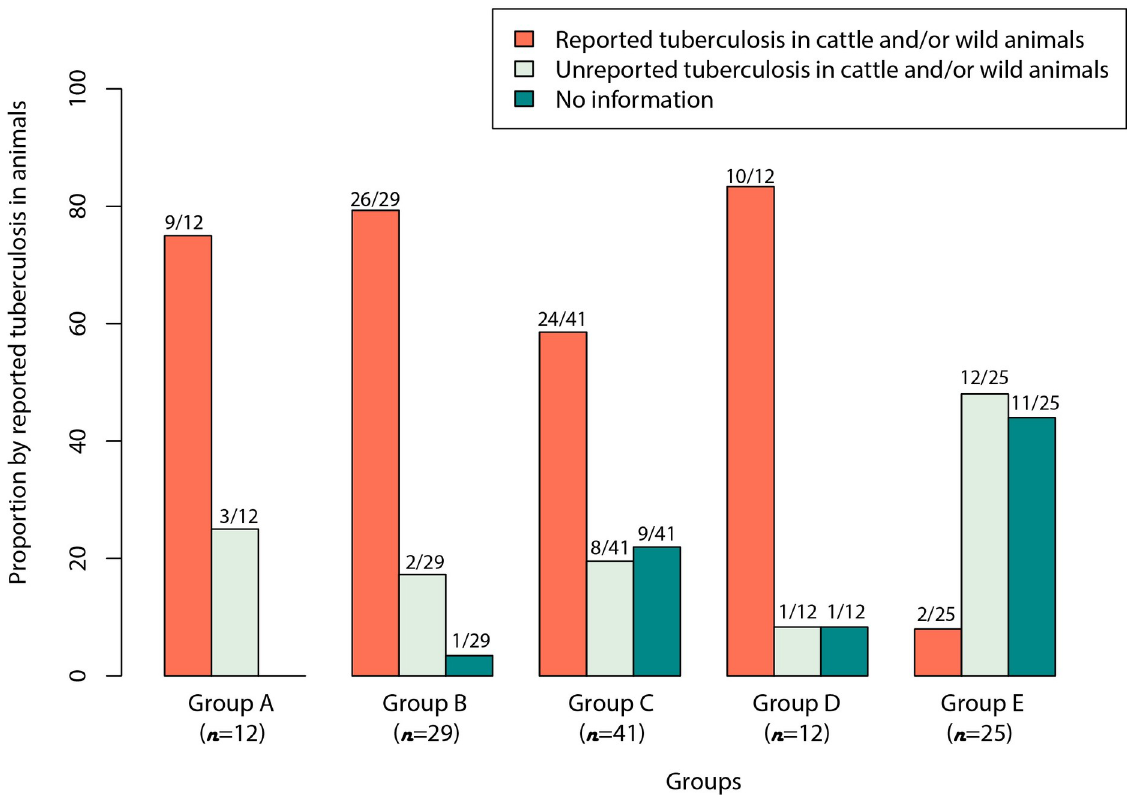
Fig 2. Distribution of countries classified in Groups A, B, C, D and E by reported tuberculosis in animals. Group A (n = 12): countries with tuberculosis surveillance with specific zoonotic tuberculosis surveillance activities (three components of surveillance: established sources for data collection; routine analysis of information available; and wide dissemination of the analyzed data). Group B (n = 29): countries with tuberculosis surveillance without zoonotic tuberculosis surveillance activities (identification of Mycobacterium bovis as a causative agent of tuberculosis in their working documents and in the national tuberculosis control programs). Group C (n = 41): countries with tuberculosis surveillance but no information on zoonotic tuberculosis from working documents available. Group D (n = 12): countries with no clear reference to existing tuberculosis surveillance or national tuberculosis control programs; no reference to zoonotic tuberculosis. Group E (n = 25): countries similar to Group D with no clear reference to existing tuberculosis surveillance or national tuberculosis control programs, and no reference to zoonotic tuberculosis, but showing some characteristics that might affect zTB epidemiology (i.e., island, city-state, population and small area).